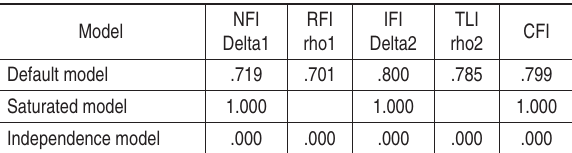
Table 2. Comparative fit index (CFI)